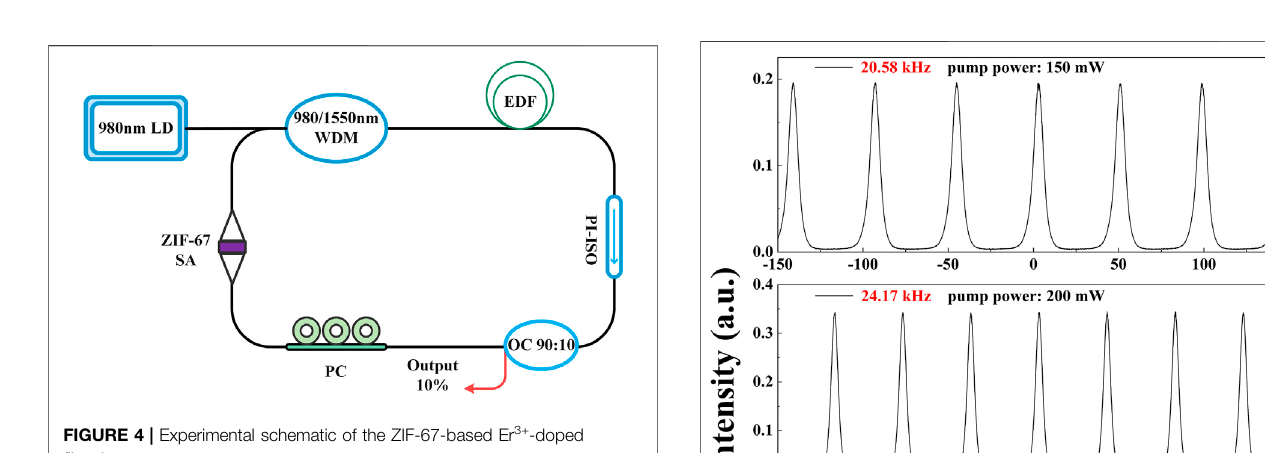
FIGURE 3 | The nonlinear optical absorption characteristics of (A) SA1 and (B) SA2.